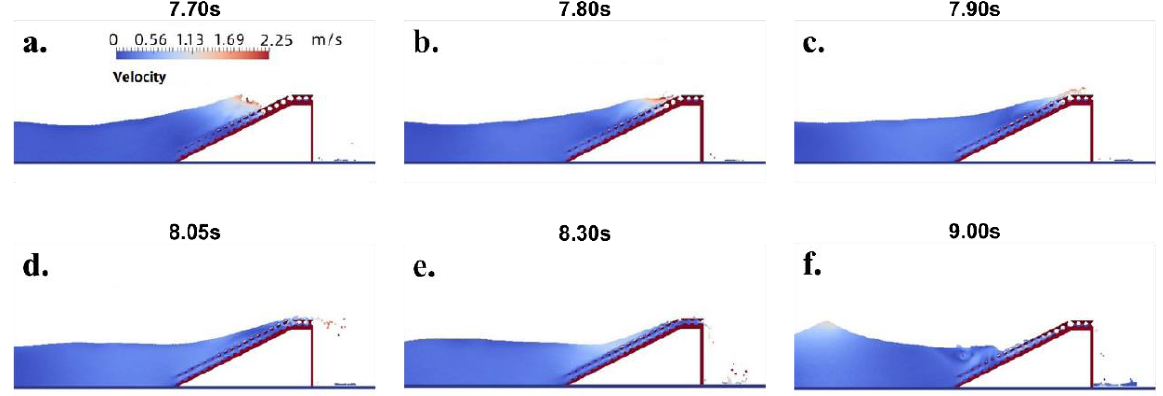
Figure 12. Wave overtopping and velocity distribution at time snapshots 7.70 s ( a ), 7.80 s ( b ), 7.90 s ( c ), 8.05 s ( d ), 8.30 s ( e ), and 9.00 s ( f ).